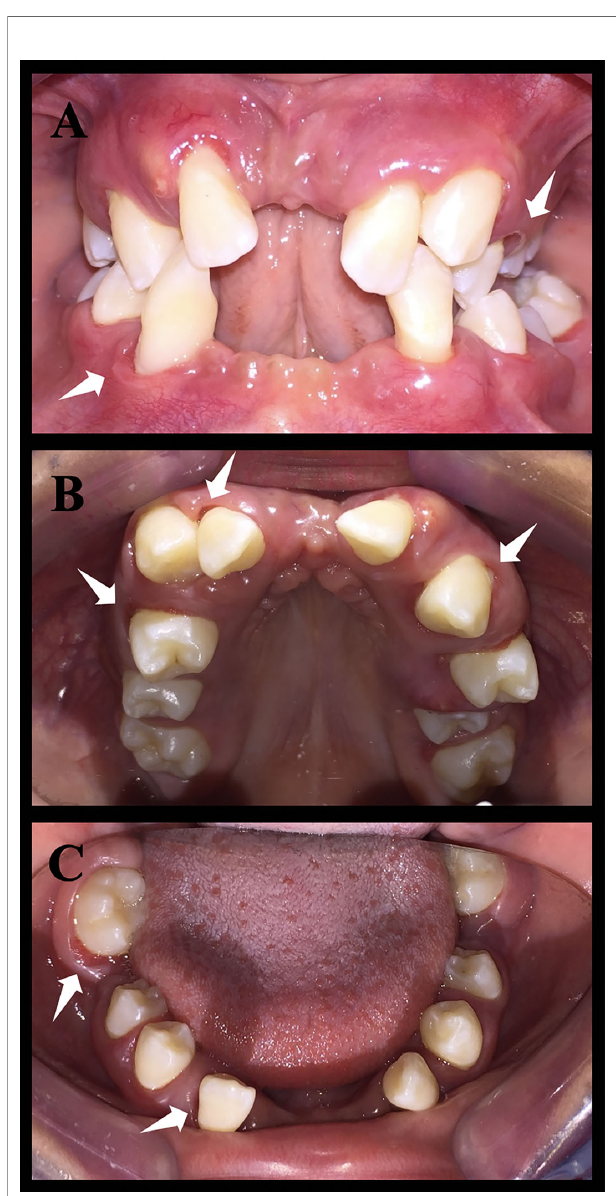
FIGURE 1 | Intraoral photos of patient Papillon – Lefèvre syndrome toothed (PLST). The white arrows indicate the periodontal pockets. It is possible to notice a signi fi cant loss of dental elements. (A) Occlusion photo of the patient. (B) Upper arch photo. (C) Lower arch